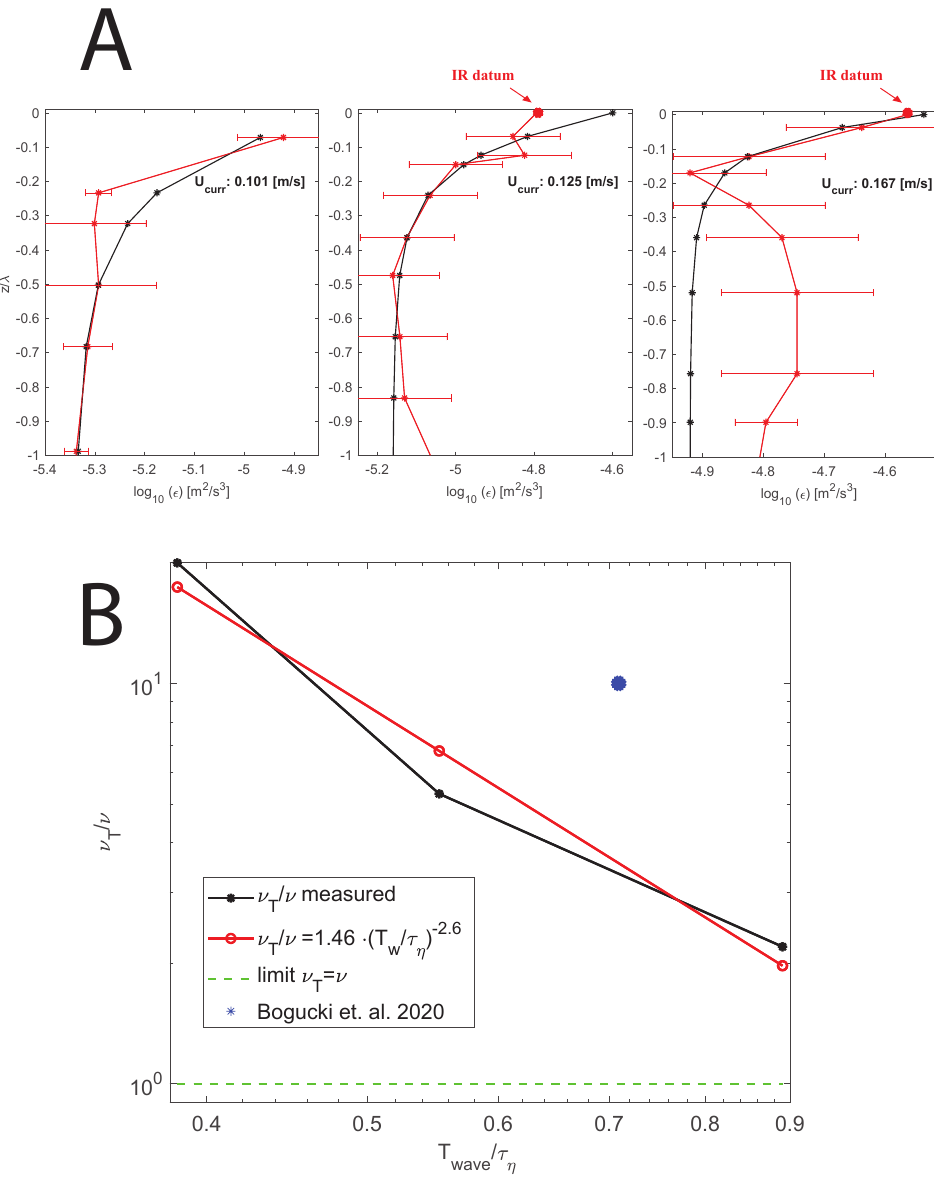
Figure 3. ( A ) Partitioned vertical TKED profiles for different current speeds U curr : red—the ob- served TKED (cid:101) T ( z ) ; black—the sum of the (cid:101) NBSW ( z ) derived from Equation (8); and the (cid:101) back —a depth-independent background TKED. The error bar corresponds to the estimated 95% confidence interval [35] of the measured TKED. The depth is normalized by the dominant wavelength in each run (Figure 1C). ( B ) The derived ν T / ν as a function of the wave period T to the Kolmogorov microscale time τ η . Fit to experimental data yielded: ν T / ν = 1.46 ( T / τ η ) − 2.6 . The blue dot—the result from NBSW measurements reported in Bogucki et al.